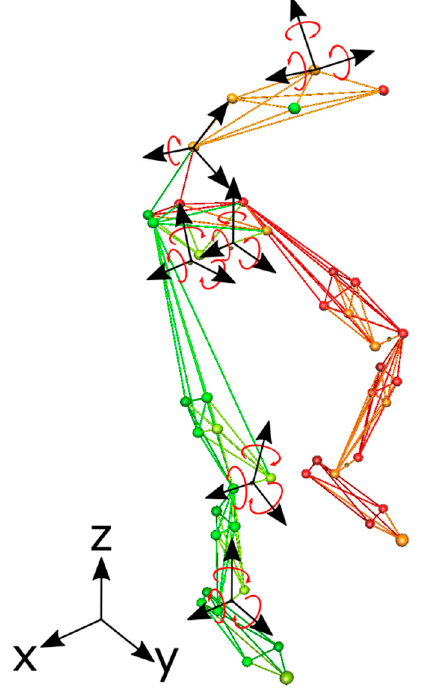
Figure 2. View of the local coordinate system of each calculated joint and segment angles. The curved arrows indicate the positive sign of each joint or segment axis.